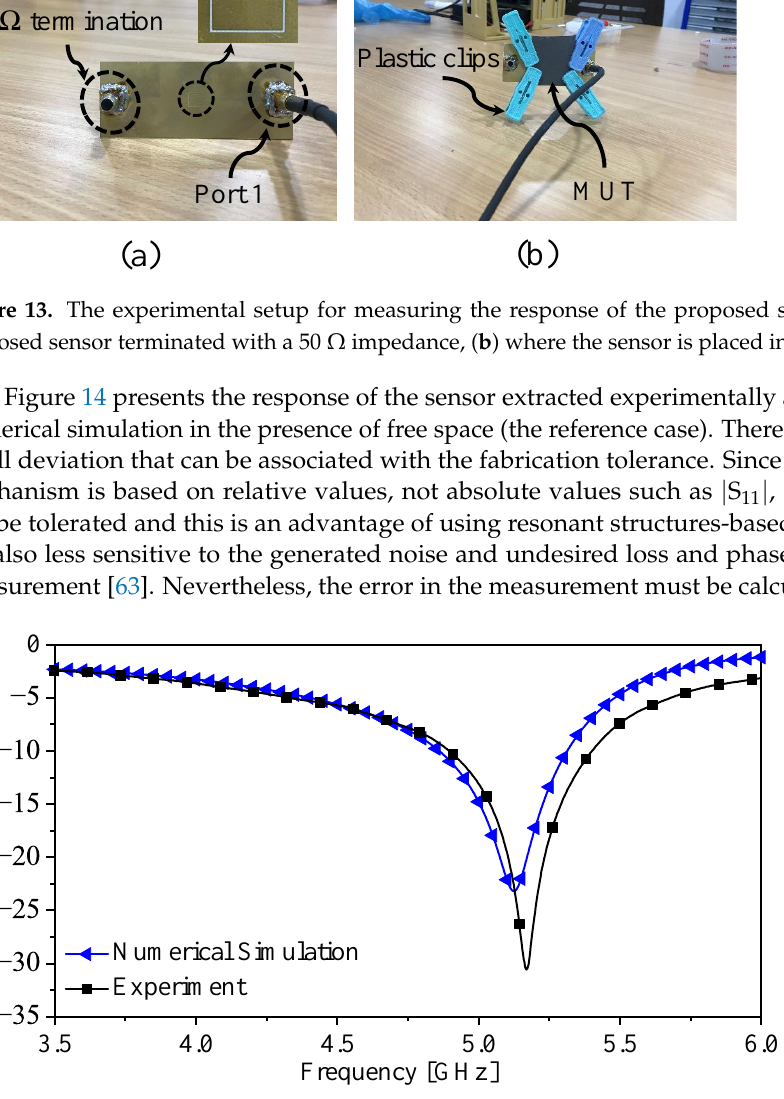
Figure 14. The response of the proposed sensor ( | S 11 | ) extracted experimentally and using the numerical simulation